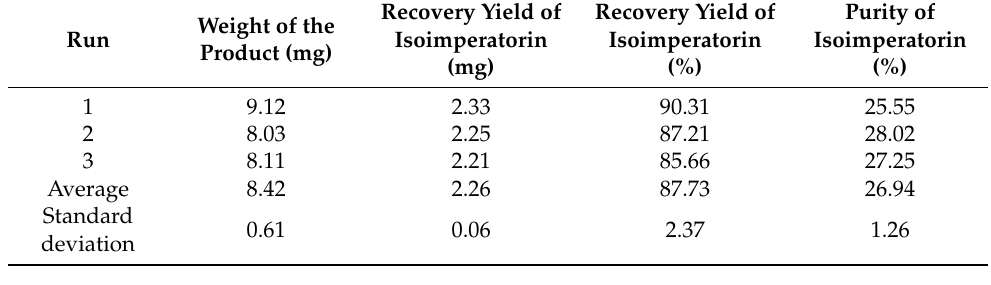
Table 4. Verification recovery experiment and purity of isoimperatorin in the product.